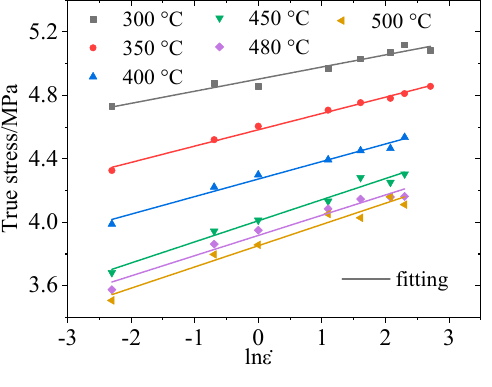
Figure 6. The fitting curves for σ − 𝑙𝑛𝜀(cid:4662) .